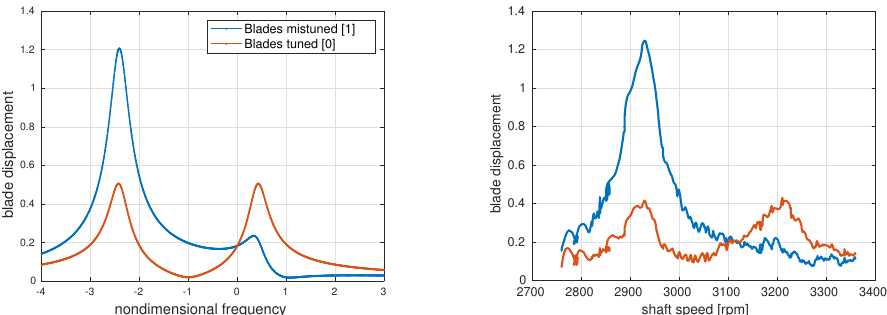
Figure 8. ROM results ( left ) and experimental results ( right ) for the alternate mistuning case [01].